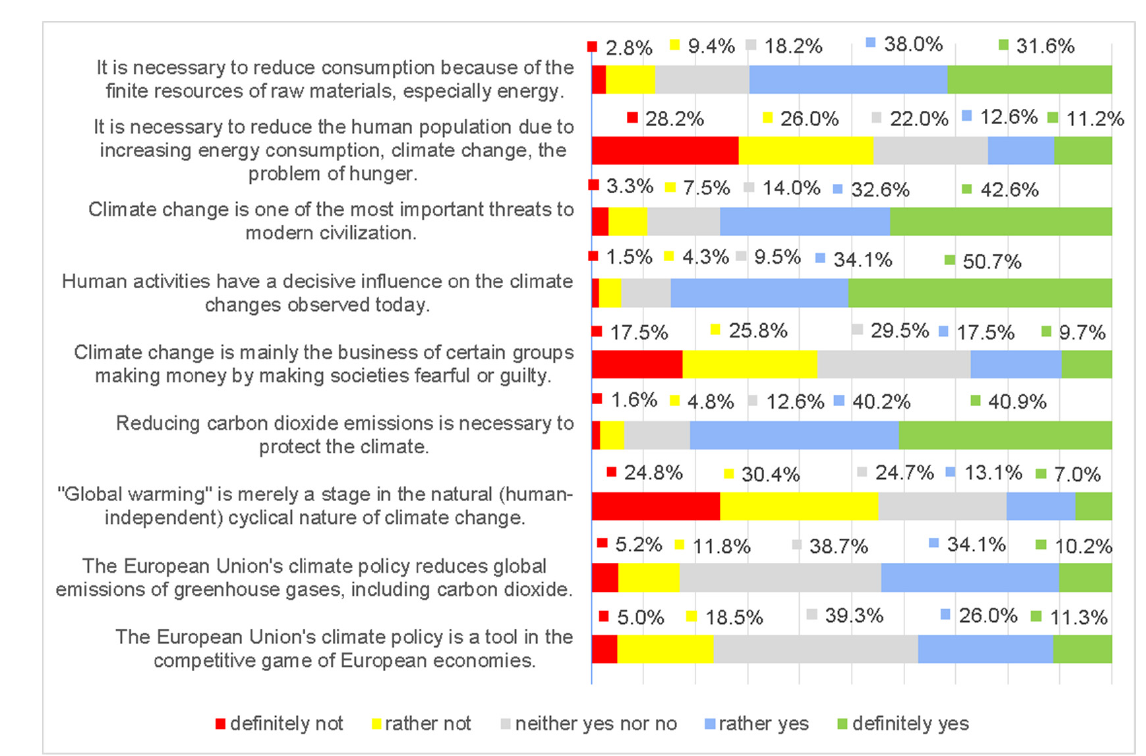
Figure 5. The structure of the assessment of theses diagnosing the perception of climate change by respondents.